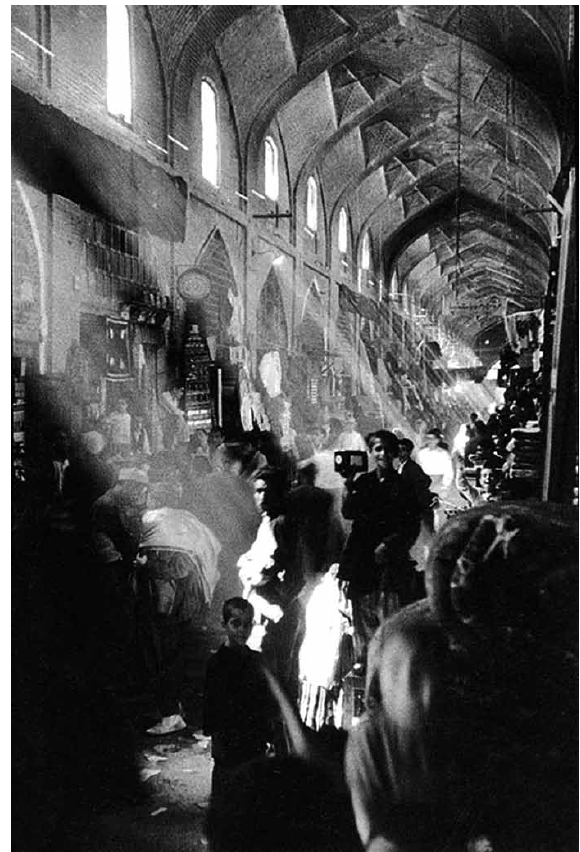
fig. 15. Shahcheragh Shrine in old city of Shiraz in Ghajar fig. 16. Vakil Bazar in 1970 (Sane